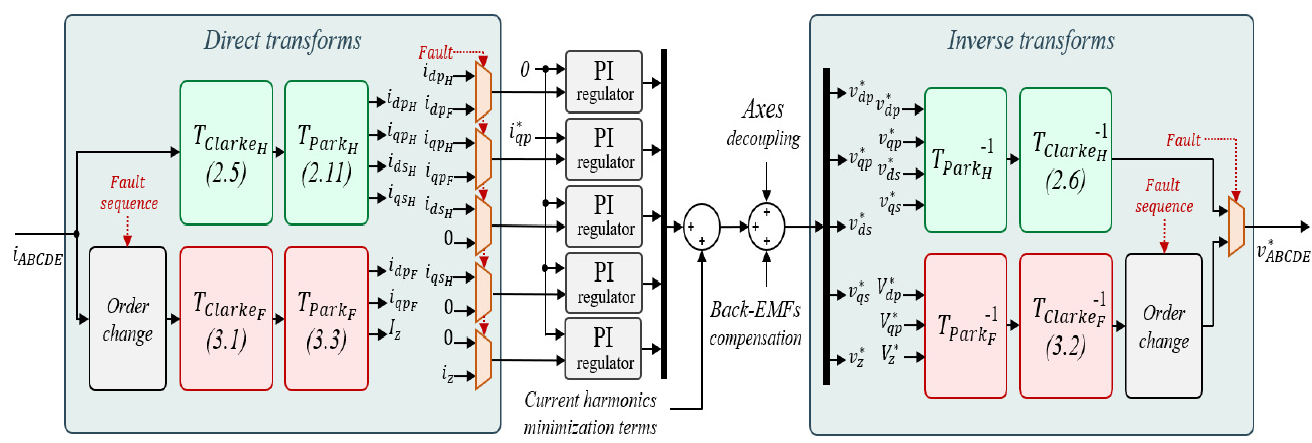
Figure 7. Overview of the reconfigurable current controller.